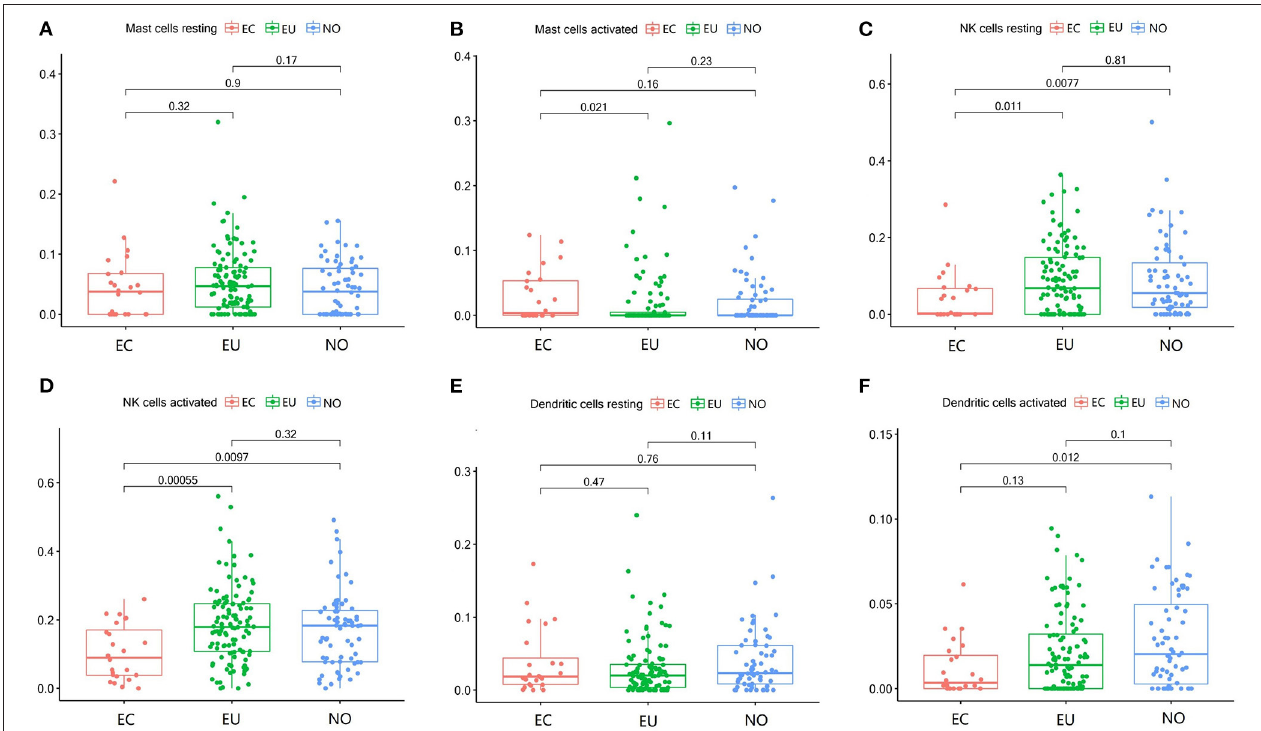
FIGURE 4 | Mast cell, dendritic cells and NK cell subgroups in EC, EU, and NO. CIBERSORT immune cell fractions were determined for each patient; each dot represents one patient. The upper quartile (P25), median value, lower quartile (P75) after removing datas with large deviation for each cell subset including resting mast cells (A) , activated mast cells (B) , resting NK cells (C) , activated NK cells (D) , resting dendritic cells (E) , and activated dendritic cells (F) were calculated for each patient group and compared using the Kruskal-Wallis test. Y axes represent the composition ratio of each immune